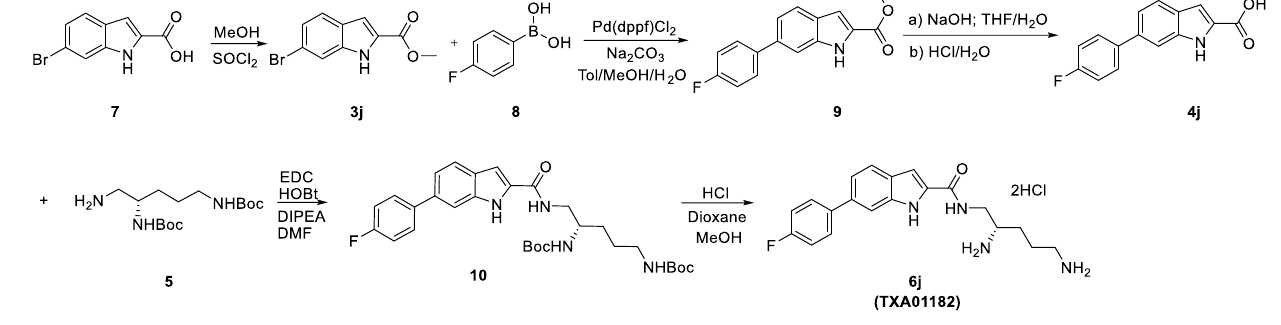
Figure 8. Synthetic scheme for compounds 6j (TXA01182).